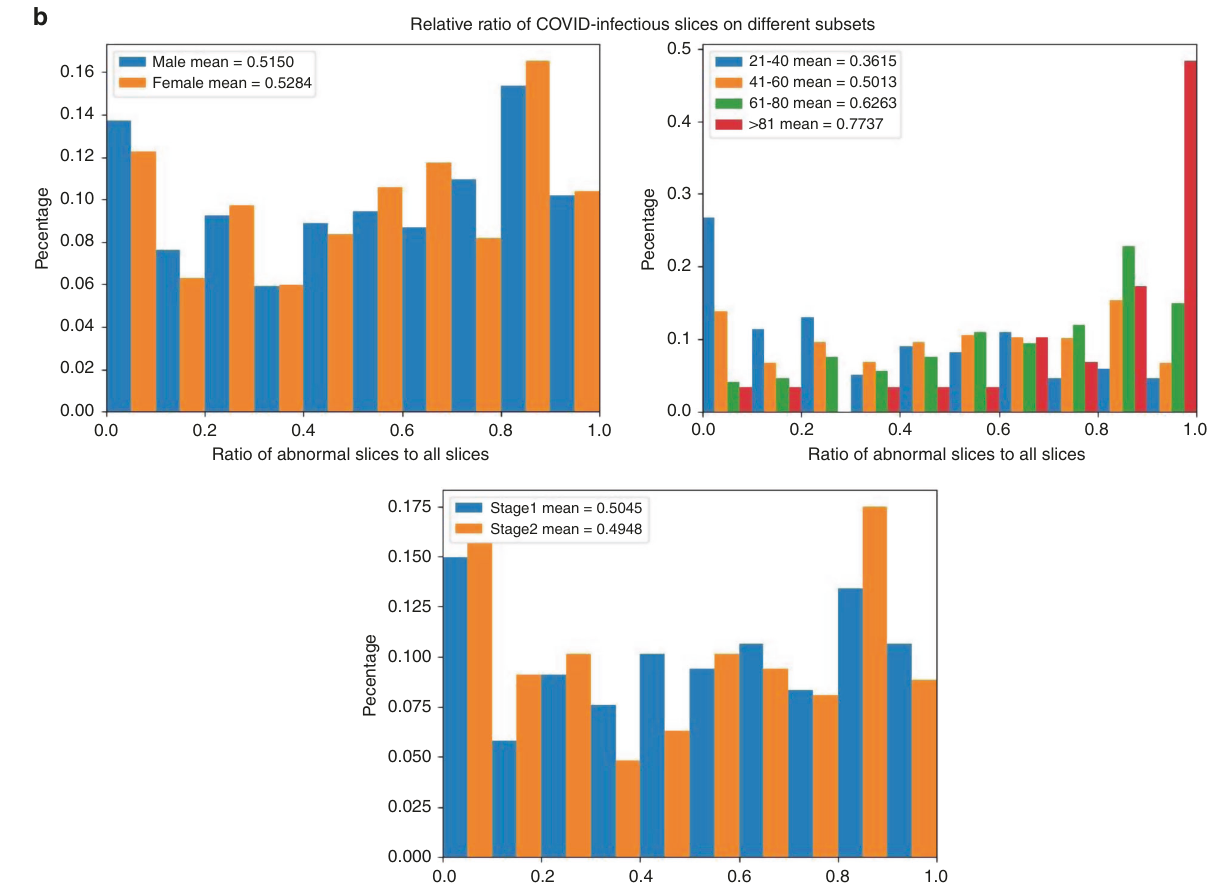
Fig. 5 Statistics on different subsets of subjects in test cohort. a AUC scores for each category on different subsets. b Distribution of ratio of COVID- infectious slices on different subsets of COVID-19